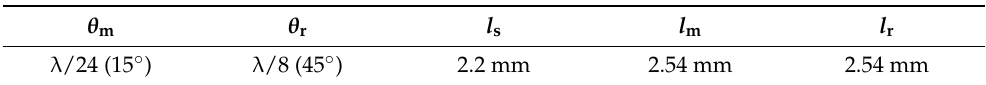
Table 2. Electrical and Physical Parameters.